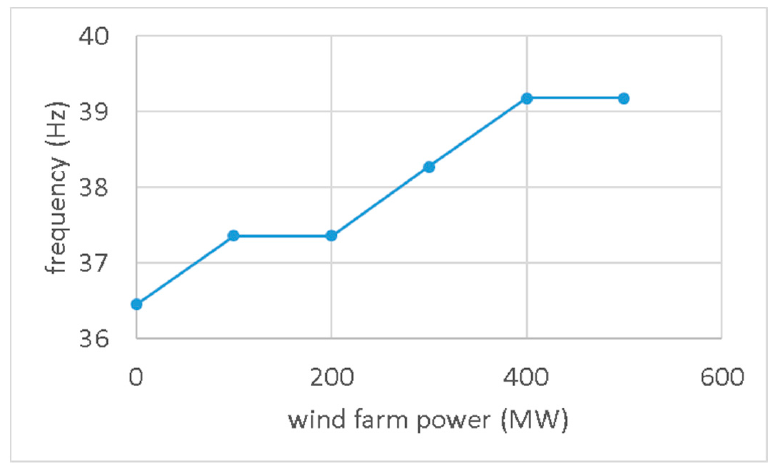
Figure 10. Frequency of resonance current.